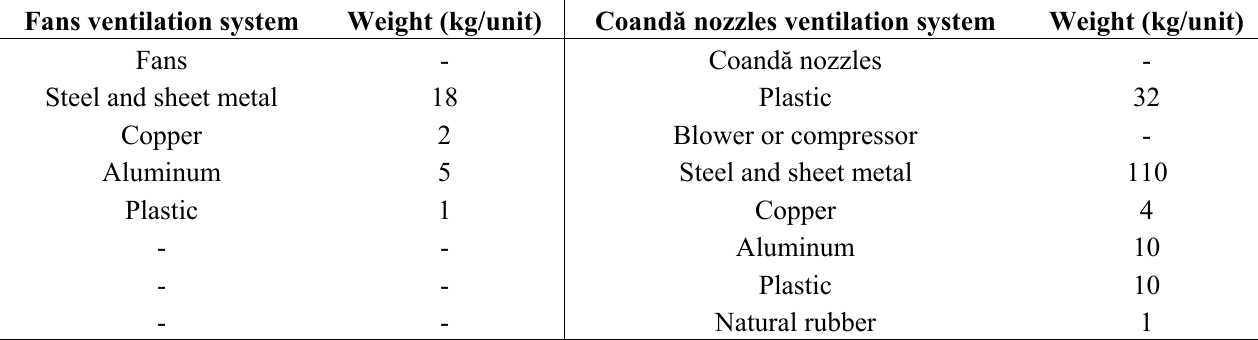
Table 3. Material weight description for both studied ventilation